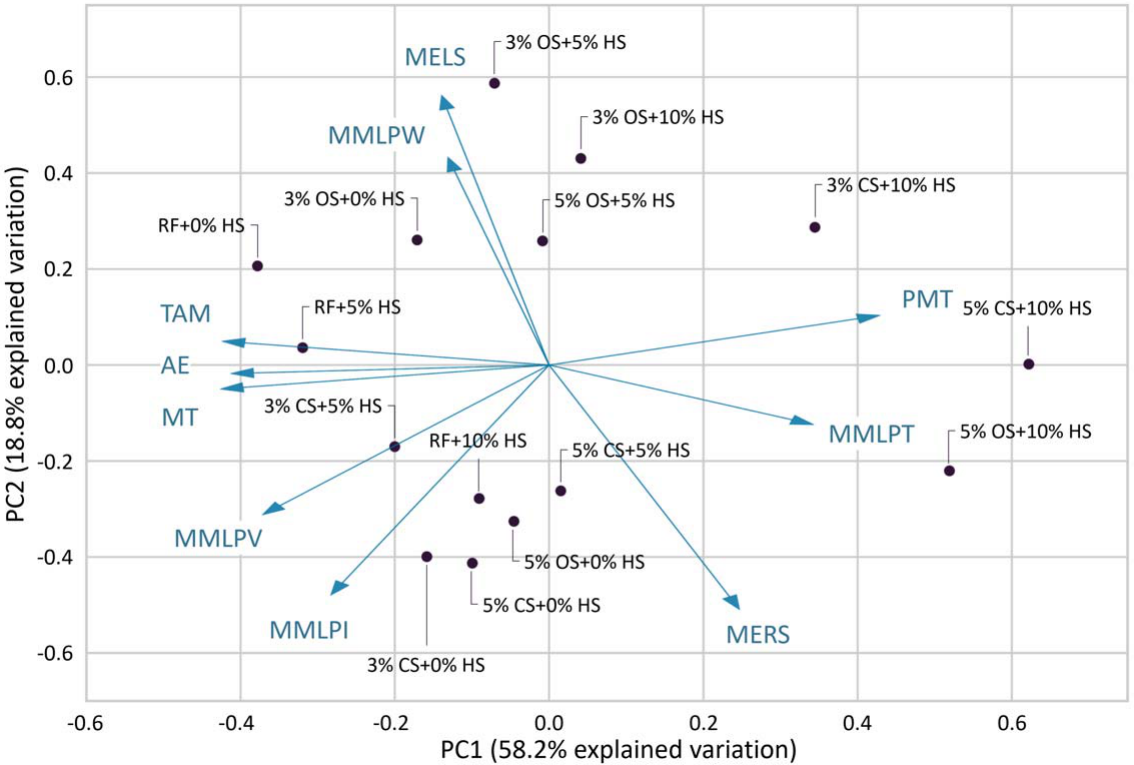
Figure 1. Biplot of principal component analysis (PCA) illustrating the overall variation among the flour samples with hazelnut skin, as well as cross ‐ linked and oxidized starches. RF = refined flour, HS = hazelnut skin, CS = crosslinked starch, OS = oxidized starch, PMT = peak maximum time, MT = maximum torque, TAM = torque after maximum, AE = aggregation energy, MELS = mixograph envelope left slope, MERS = mixograph envelope right slope, MMLPT = mixograph MID line peak time, MMLPV = mixograph MID line peak value, MMLPW = mixograph MID line peak width, MMLPI = mixograph MID line peak integral.